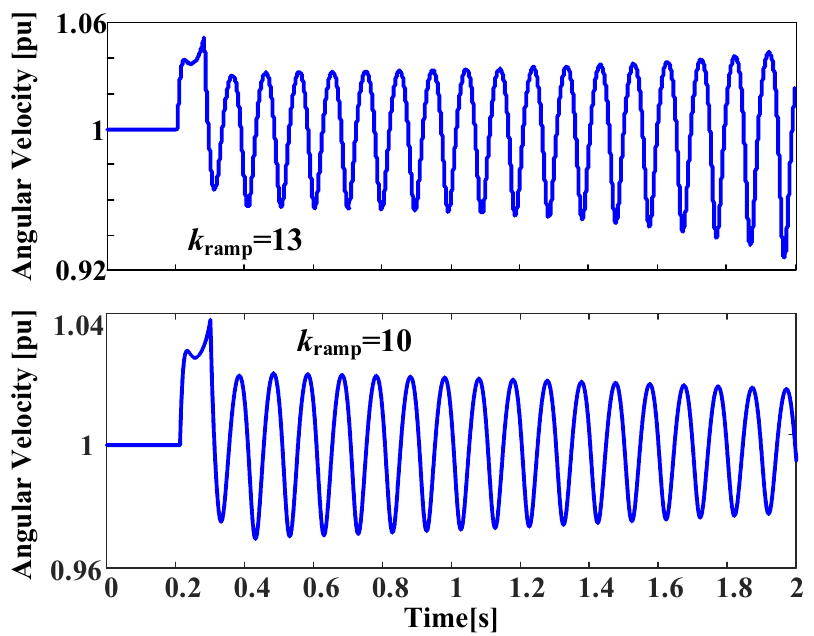
Figure 20. Comparative simulated results at different ramp rate limit.